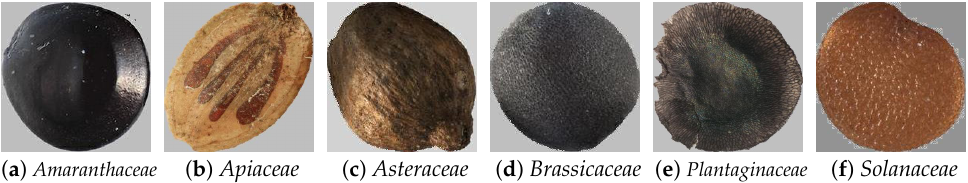
Figure 1. Samples of seed for each family present in the Canadian data